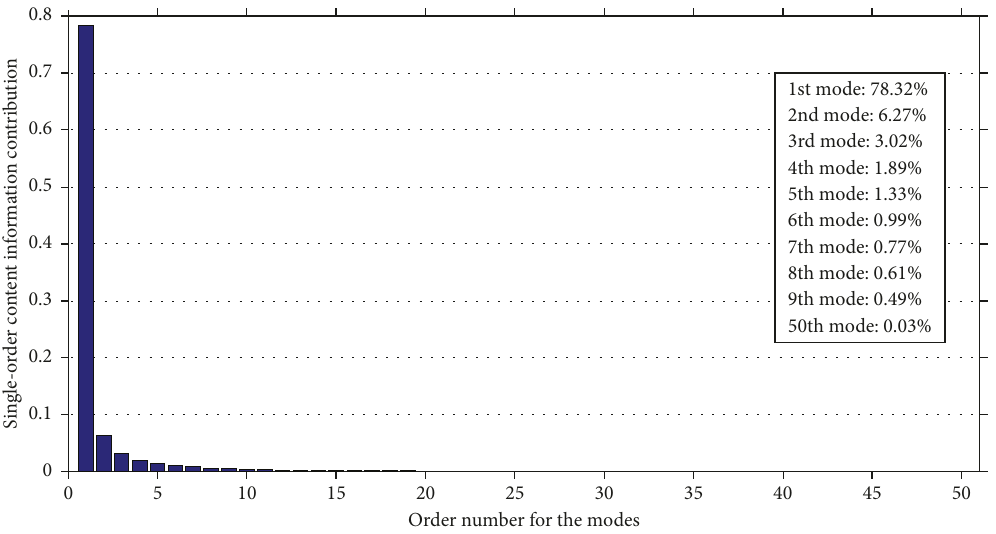
Figure 11: Single-order content information contribution for the first 50 modes in the subsequent stage of flame